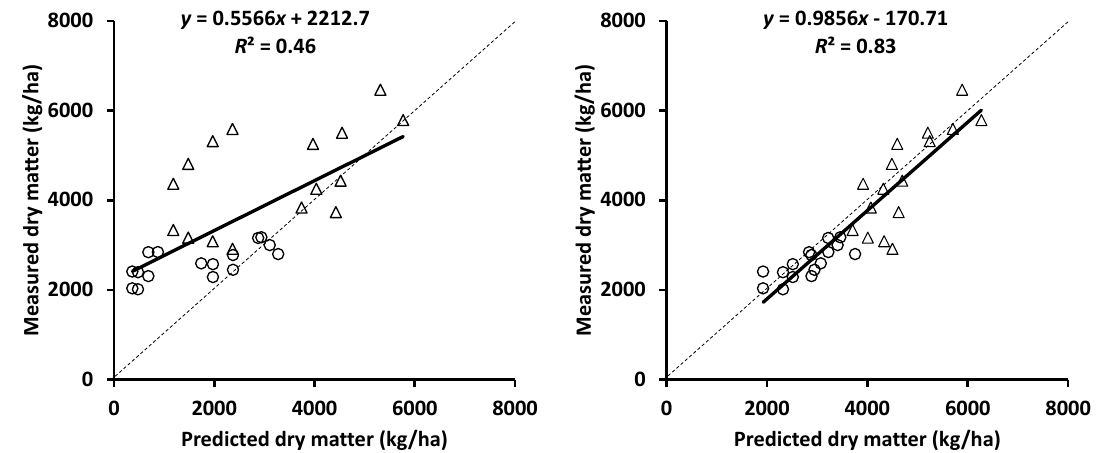
Figure 5. Relationship between observed dry matter and that predicted using the APSIM mungbean model with extinction coefficients ranging from 0.3 to 0.58 ( left panel ) and 0.45 to 0.58 ( right panel ) for the mungbean cultivar ‘Crystal’ at 57 days after sowing at Emerald (circle) and 97 days after sowing at Hermitage (triangle) [48] .